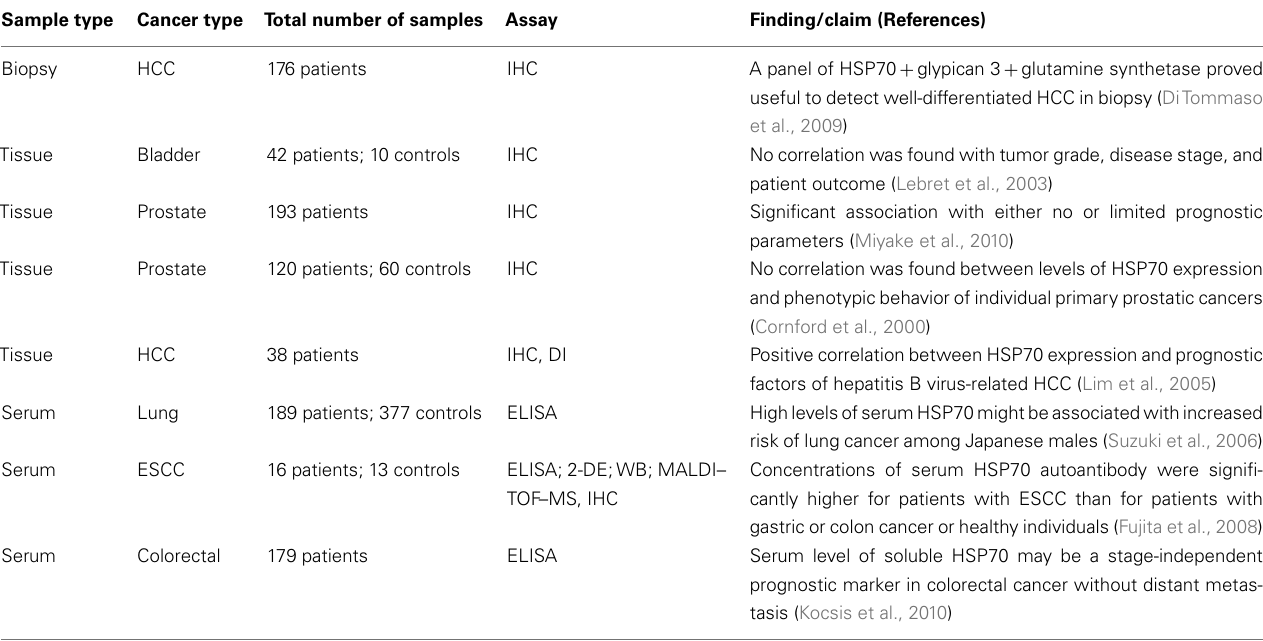
Techniques are: 2-DE, two-dimensional gel electrophoresis; ELISA, enzyme-linked immunosorbent assay; IHC, immunohistochemical analyses; MALDI–TOF–MS, matrix-assisted laser desorption/ionization – time-of-flight – mass spectrometry; DI, dot immunoblot;WB, western blot. ESCC, esophageal squamous cell carcinoma; HCC, hepatocellular